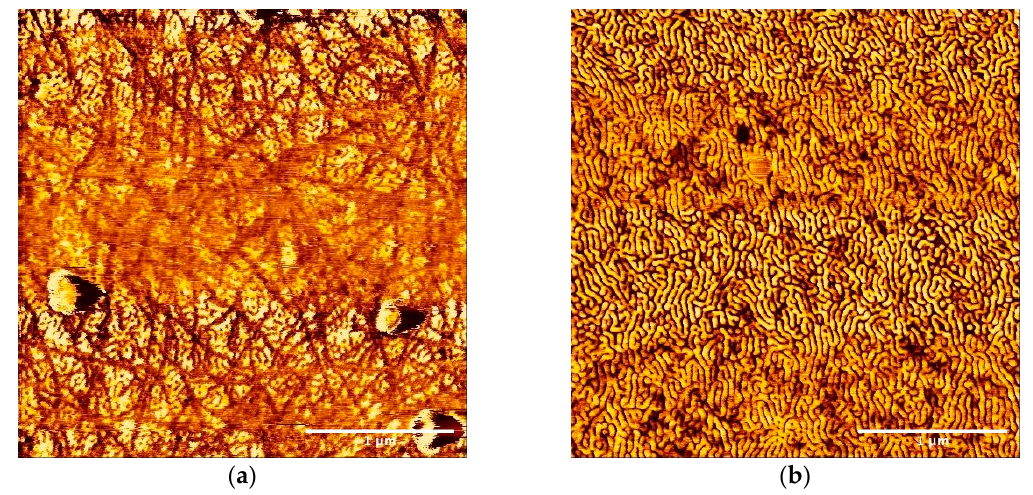
Figure 5. SFM phase image of the thin film obtained by spin-casting the suspension of P3HT (0.05 wt%) and SBS (0.5 wt%) in the mixture of chloroform and anisole (70:30 ( v / v )) (3 × 3 μ m) in ( a ) unstretched and ( b ) stretched parts after the elongation treatment.